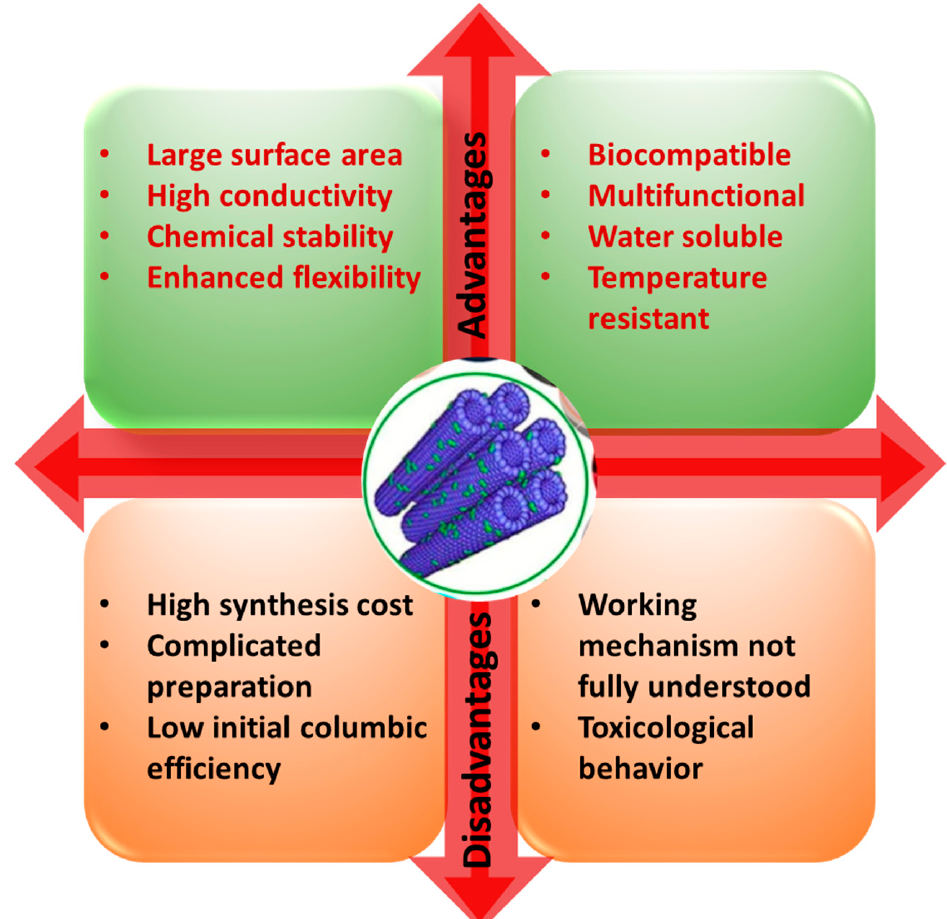
Figure 1. Schematic showing the advantages and disadvantages of carbon nanotubes. CNTs exhibit chirality and diameter-based physicochemical properties and are also shown to have enhanced cell penetration properties and stability. Studies have demon- strated the efficacy of CNTs in anticancer drug delivery. In this context, Joshi et al. compared the delivery of the anticancer drug methotrexate (MTX) using aminated multi-walled car- bon nanotubes (MWCNTs) with aminated fullerenes as carriers in MDA-MB-231 breast cancer cells [11]. The results clearly showed that, in comparison to MWCNTs-MTX, MTX- fullerenes displayed better cytotoxic effects and higher circulation times. However, bio- corona formations of MWCNTs were significantly lower than that of the fullerenes, which resulted in enhanced bioavailability of MWCNT-MTX in comparison to MTX-fullerenes. Thus, during in vivo study, MWCNT-MTX displays better anti-tumoral effects at lower doses when compared to MTX-fullerenes. Ex vivo hemolysis results also showed the enhanced biocompatibility effect of the MWCNT-MTX composite. Issues such as cellular toxicity, incompatibility with biological mediums, agglomera- tion, accumulation, and long-term persistence are some of the major drawbacks which limit the application of CNTs in real scenarios. Therefore, in the field of biomedical application, there is an urgent requirement to develop CNTs with enhanced biocompatibility. Surface functionalization, purity, surface area, and length are a few of the physicochemical proper- ties that play a major role in governing the biocompatibility of CNTs [12]. Reports clearly showed that, in comparison to pristine CNTs, surface-functionalized CNTs are less toxic. Additionally, surface modification, via the use of cell-specific biomolecules, promotes the targeting ability of CNTs [13], thus reducing their systemic toxic effect and immunogenic- ity [14]. Functionalization can be achieved by linking specific functional groups to the